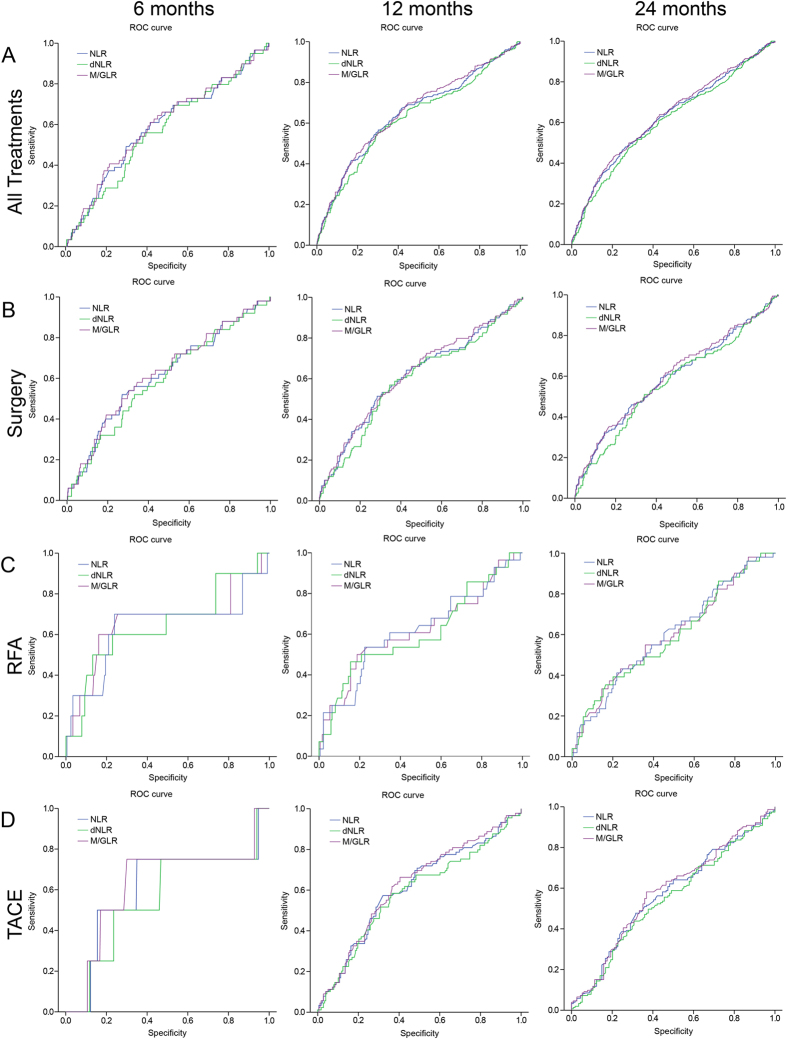
Comparison of the AUC for outcome prediction among NLR, dNLR, and M/GLR for patients with HCC after treatment.(A) All Treatments, (B) surgery, (C) RFA, (D) TACE.